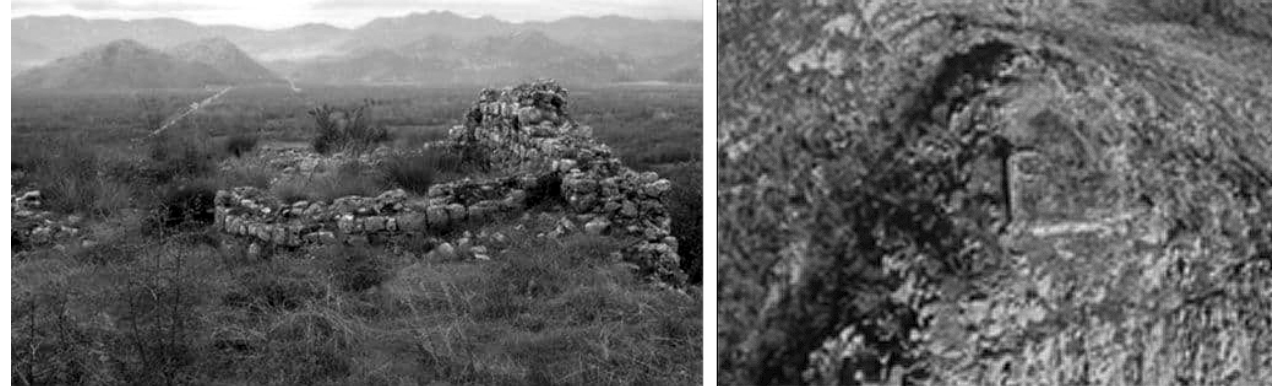
Figure 4. Balsin Grad (Photo: D. Starcevic) .